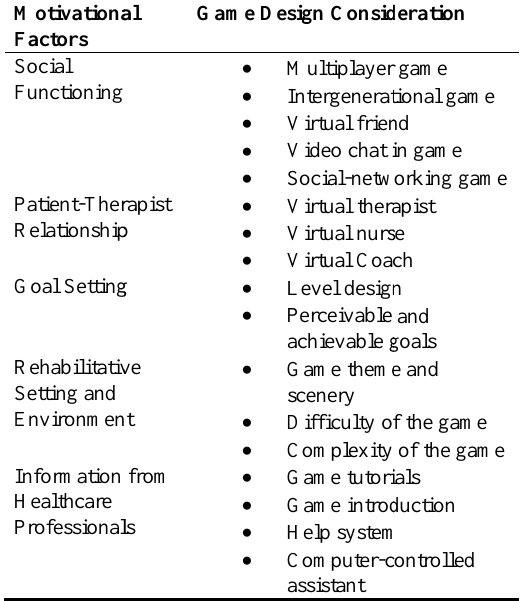
Motivationa Factors Social Functioning